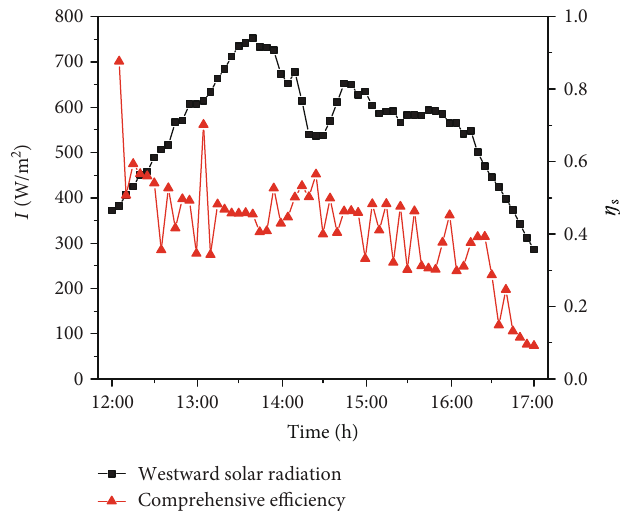
Figure 9: The comprehensive e ffi ciency of the PV/T façade